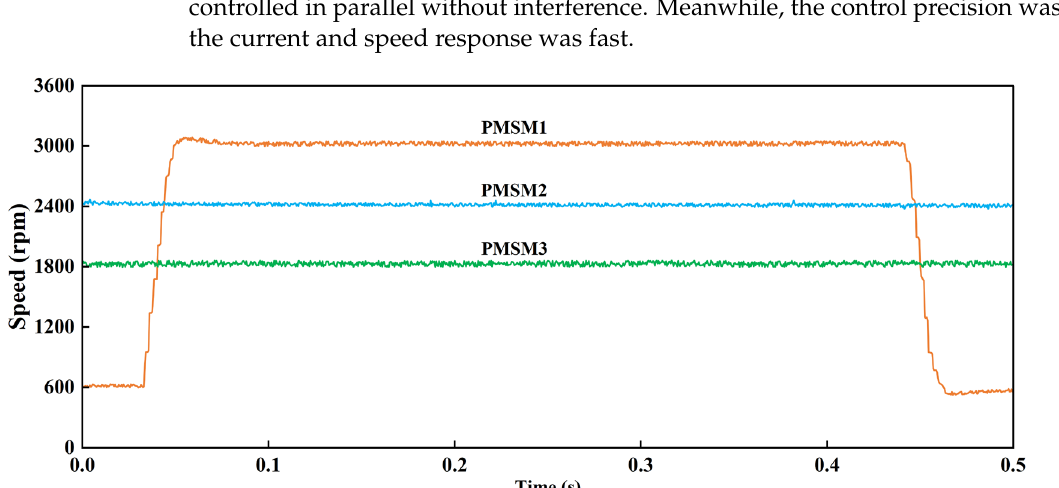
Table 3. Comparison of computation